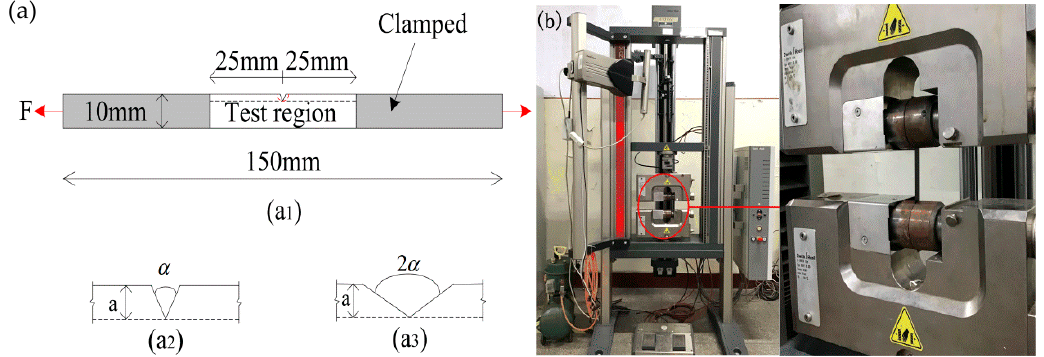
Figure 2. Uniaxial tensile test of composites with different angle notches: ( a ) sample size; ( b ) tensile test.